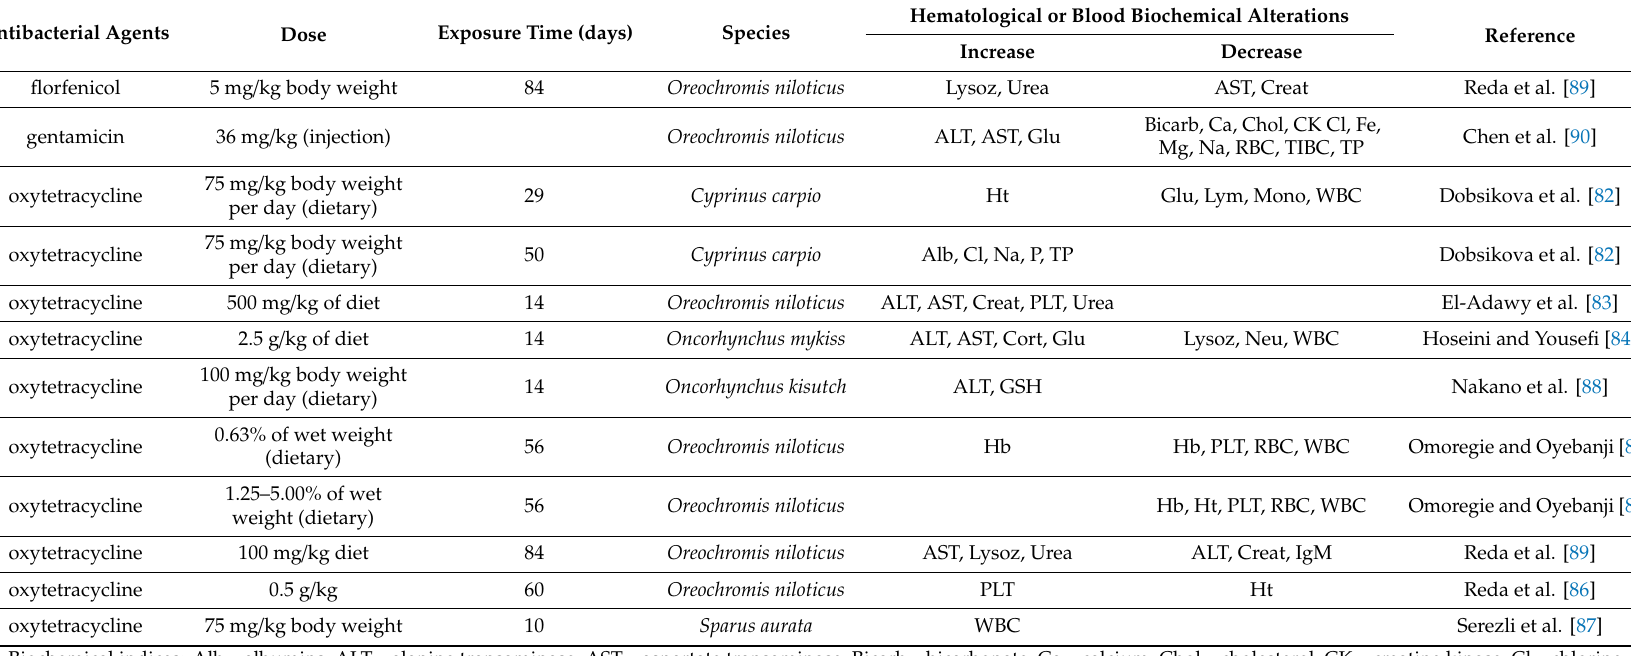
Table 2. E ff ects of antibacterials on hematological and blood biochemical parameters in